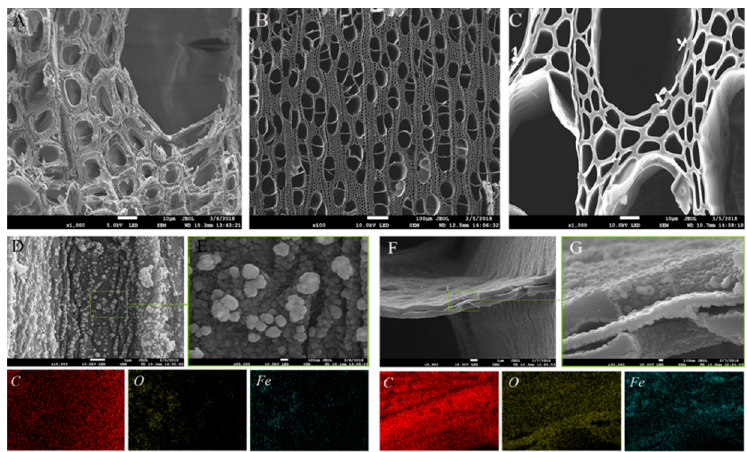
Figure 1. SEM images of the longitudinal sections of untreated wood ( A ) and pyrolysized wood (magnetic biochar) in different magnifications ( B , C ). ( D – G ) The SEM images of pyrolytic wood with the radial sections, cross sections and the corresponding EDS mapping results of C, O, Fe.